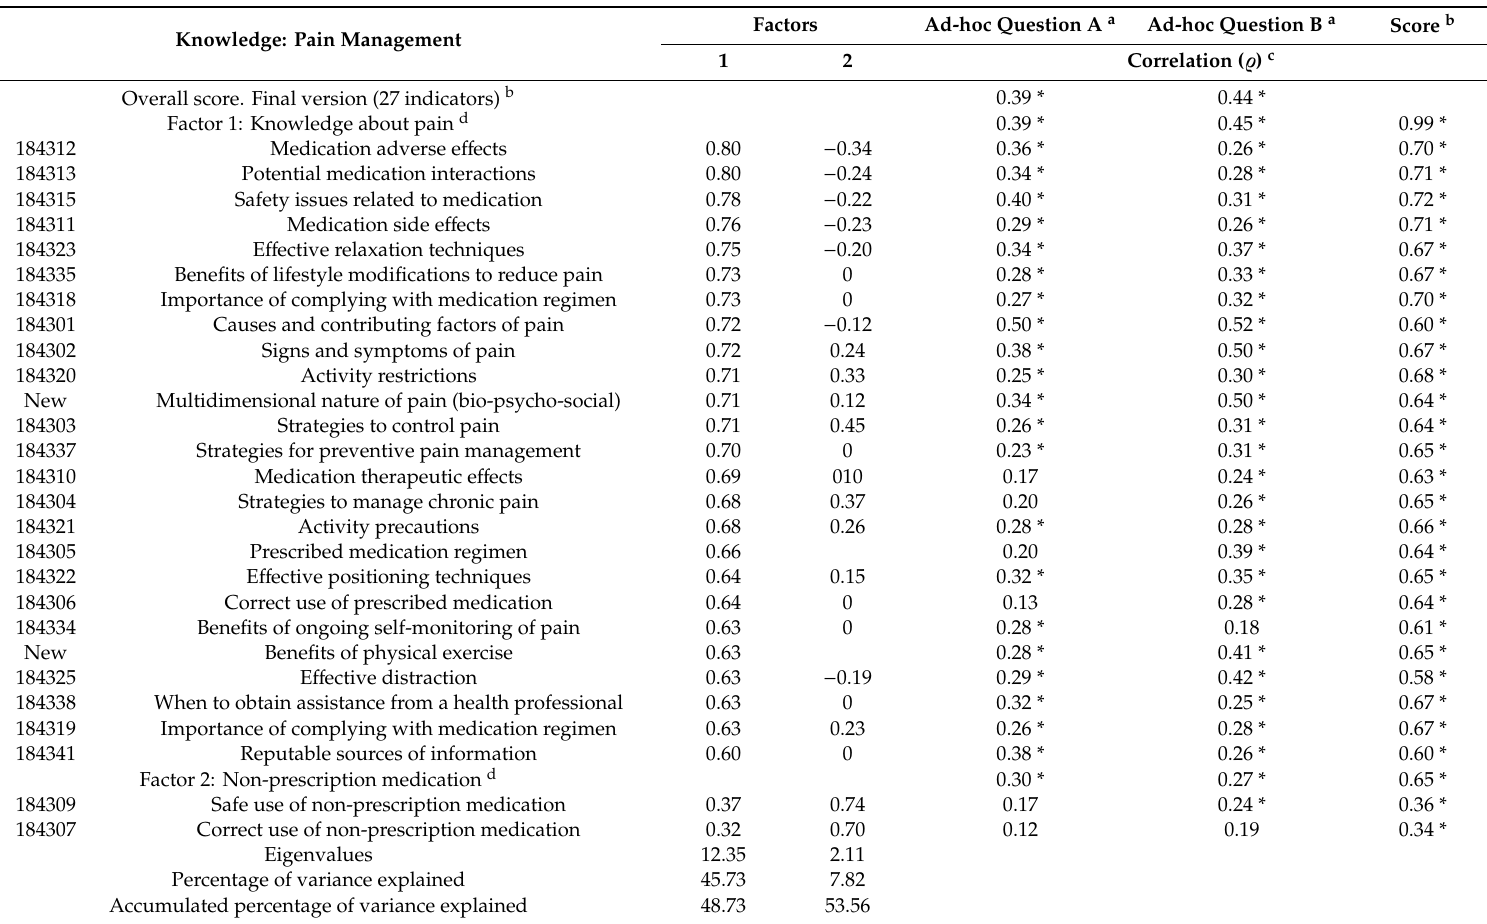
Table 5. Construct validity (principal component analysis with quartimax rotation) and criterion validity for the outcome Knowledge: Pain